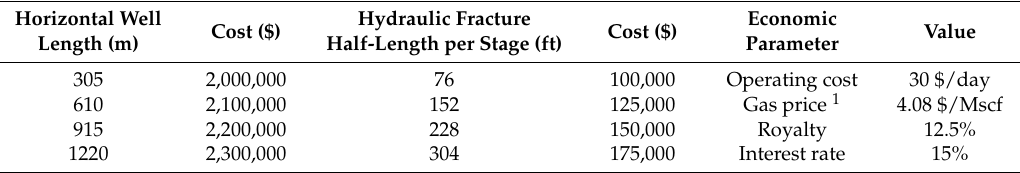
Table 4. Economic data for net present value (NPV) calculation [16].